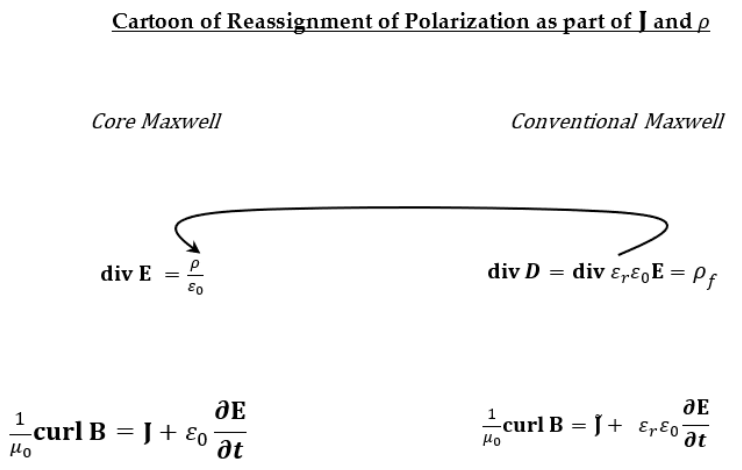
~ Figure 2. Classical and Core Maxwell equations. J describes the flux of mass with charge, after the usual dielectric term is subtracted from J . ρ f describes the distribution of charge after the usual dielectric term is subtracted from ρ . The charge ρ describe all charges, however small, and all flux J (of charges with mass), however fast, brief, and transient. They include polarization phenomena in the properties of ρ and J whereas the classical equations use an oversimplified representation (see text) that describes the polarization of an idealized dielectric by its dielectric constant ε r with the appropriately modified definitions of charge and flux, namely the free charge ρ f and (cid:101) J